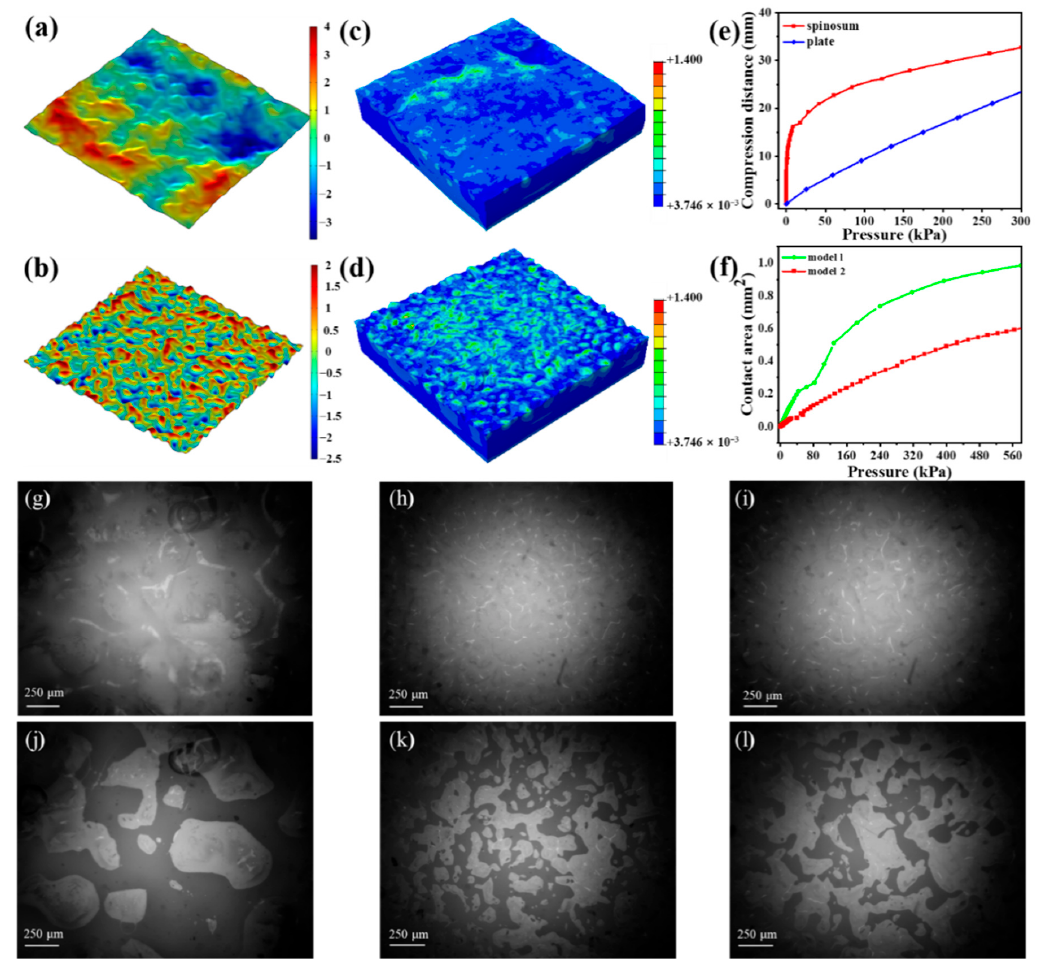
Figure 5. Sensing mechanisms of the pressure sensors. Schematic of the simulation ( a ) model 1 and ( b ) model 2 with different spinosum microstructures. FEA simulation showing the stress distribution of ( c ) model 1 and ( d ) model 2 at a pressure of 100 kPa. ( e ) The FEA simulation result of the compression distance variation for the spinosum and plate dielectric layer. ( f ) The FEA simulation result of the contact area variation between the dielectric layers with different architectures. The image of the spinosum dielectric layer using different abrasive papers no. ( g ) 80, ( h ) 320 and ( i ) 600 without pressure. The image of the contact area of the spinosum dielectric layer using different abrasive papers no. ( j ) 80, ( k ) 320 and ( l ) 600 at a pressure of 180